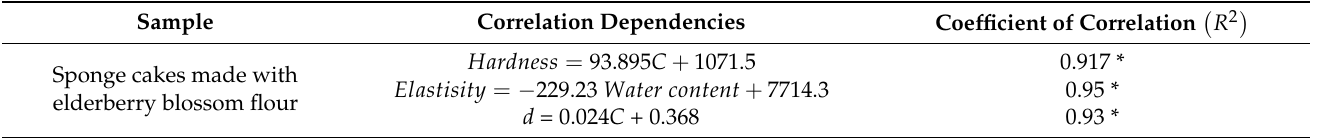
Table 4. Correlation dependencies for sponge cake layers related to textural parameters.